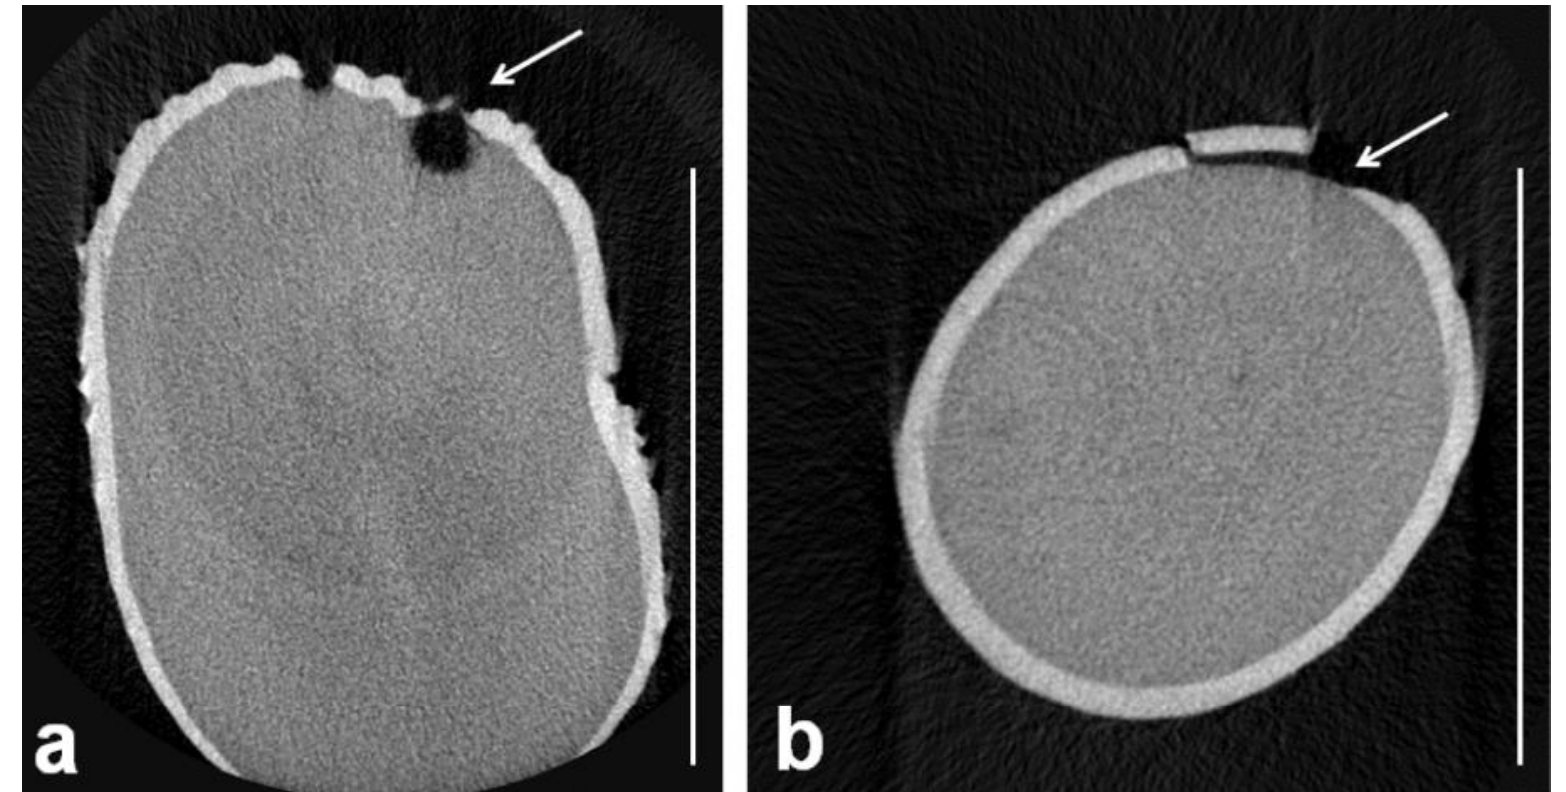
Fig. 5. Micro-CT cross-sections of odontocete teeth evidencing pathological conditions and abnormalities. Scale bar = 10 mm. a) Caries-like lesion in the Amazon river dolphin Inia geoffrensis (IEPA 1899). b) Worn desiccated enamel of the bottlenose dolphin Tursiops truncatus (UFSC